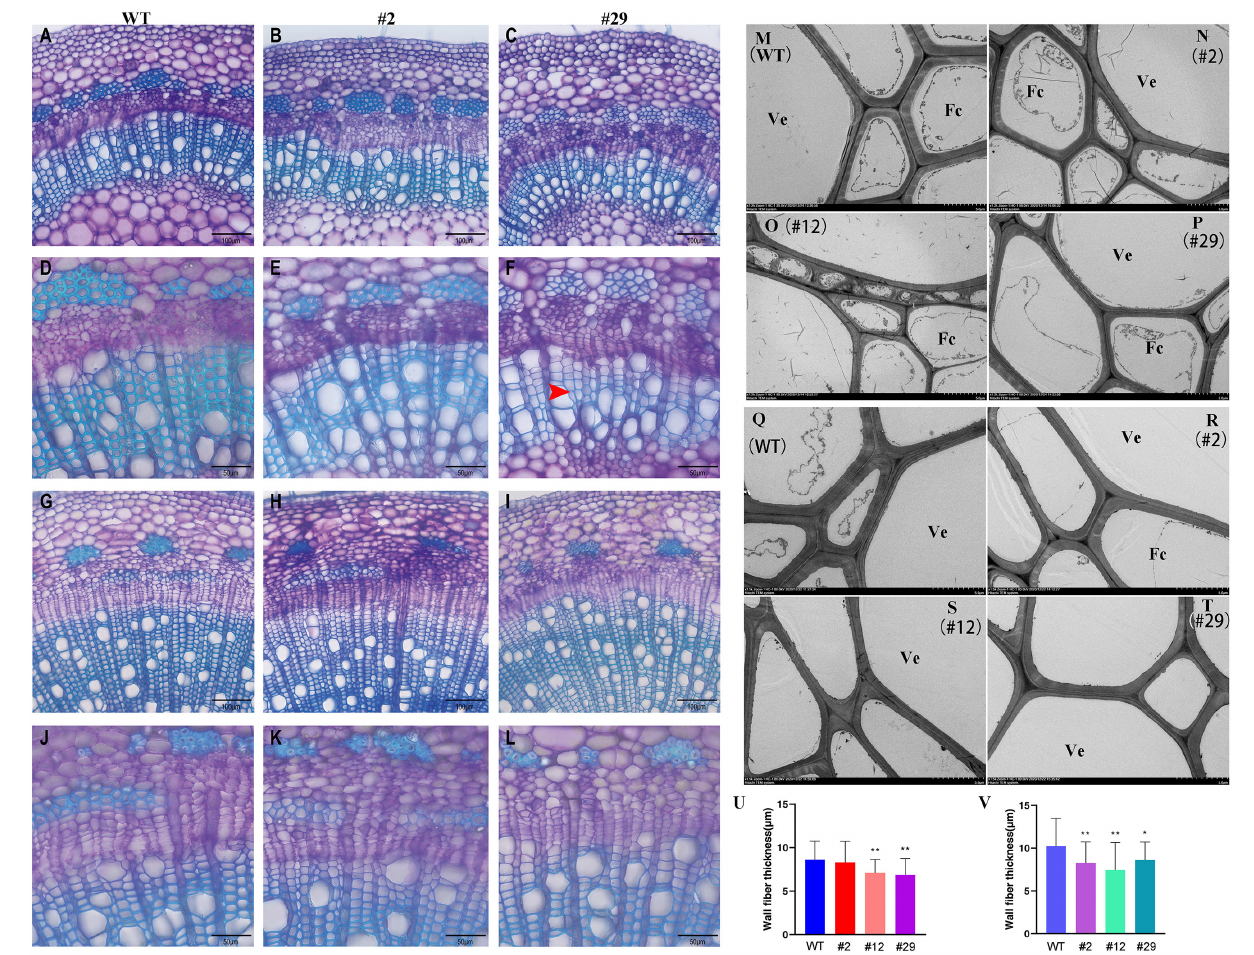
FIGURE 7 | Comparison of xylem structure between P. alba × P. glandulosa BLH6a dominant repression transgenics and WT. (A–L) Light microscopy. (A–C) Cross sections of the seventh internode from WT (A) , transgenic lines 2 (B) , and 29 (C) at 200 magnification. (D–F) Cross sections of the seventh internode from WT (D) , transgenic lines 2 (E) , and 29 (F) at 400 magnification. (G–I) Cross sections of the 14th internode from WT (G) , transgenic lines 2 (H) , and 29 (I) at 200 magnification. (J–L) Cross sections of the 14th internode from WT (J) , transgenic lines 2 (K) , and 29 (L) at × 400 magnification. Bars = 100 µ m in (A–C , G–I) and 50 µ m in (D–F , J–L) . The red arrow shows the thinner cell wall. (M–T) Transmission electron microscopy. (M–P) Cross-sections of the eighth internode from WT (M) , transgenic lines 2 (N) , 12 (O) , and 29 (P) . (Q–T) Cross-sections of the 14th internode from WT (Q) , transgenic lines 2 (R) , 12 (S) , and 29 (T) . Bars = 5 µ m. Ve, Vessel; Fc, Fiber